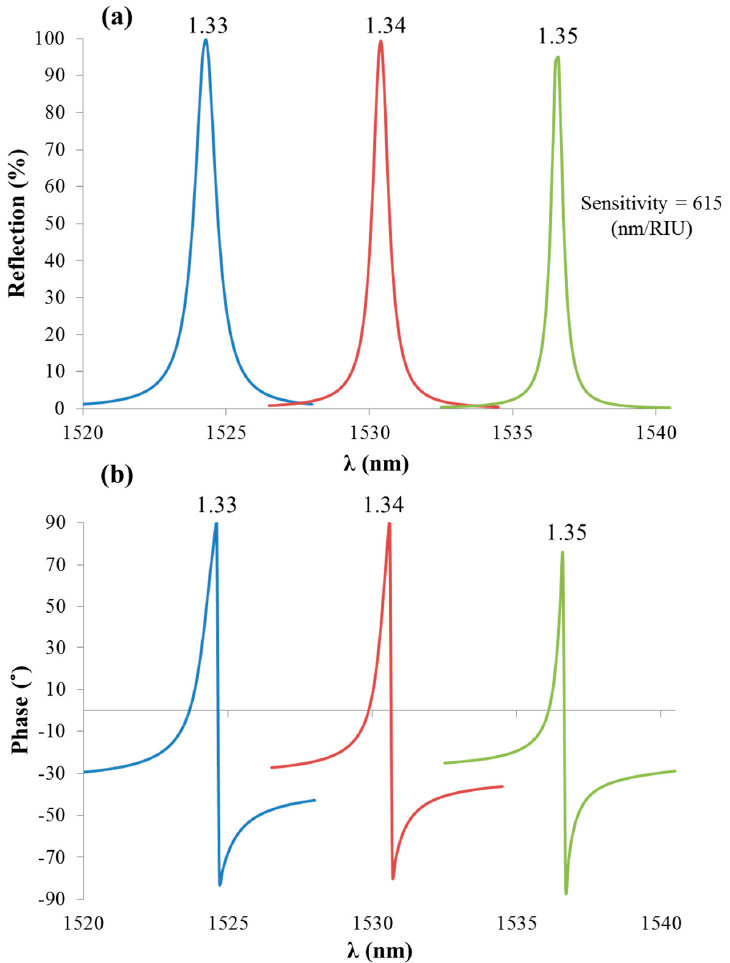
Figure 14. ( a ) Reflection spectra from the thick SW dielectric grating geometry at different analyte RIs. ( b ) Phase response at the same RIs as in Figure 14a. TE-polarized light under normal incidence was used in the simulations of the Si 3 N 4 grating with Λ = 1000 nm, h = 1000 nm, and FF = 0.4. SiO 2 was used for the substrate.